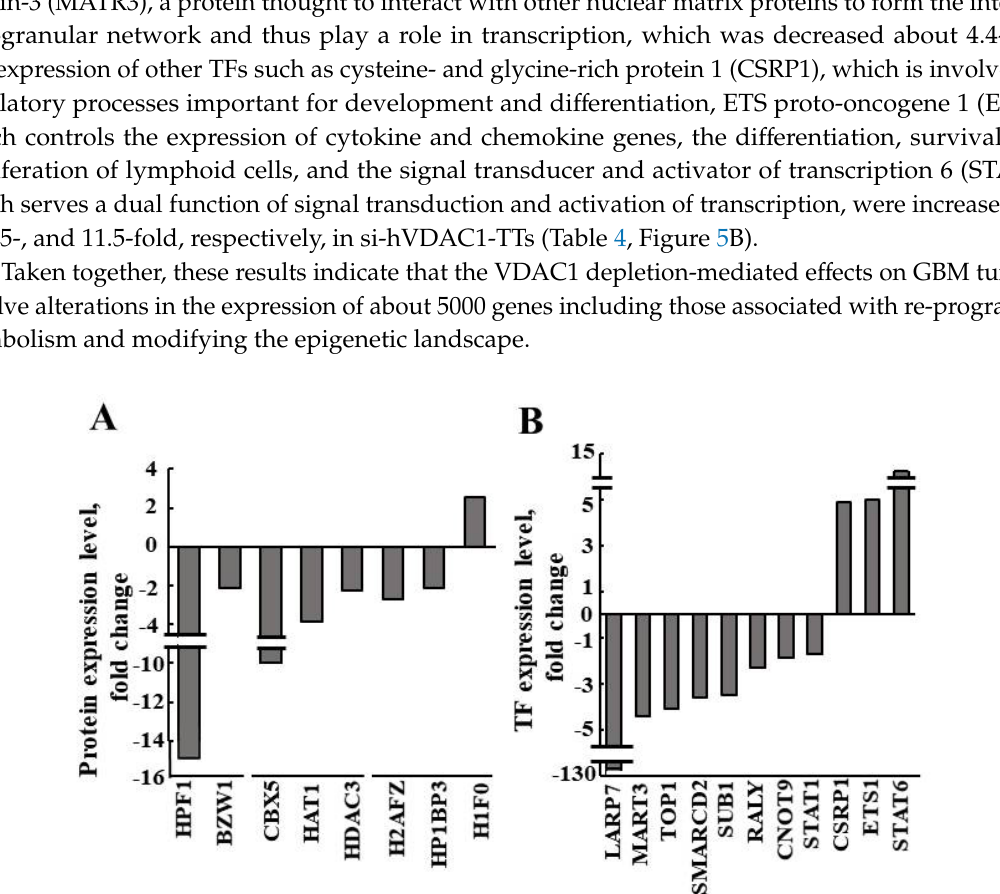
Table 3. Histones and histone-associated proteins differentially expressed in si-NT-TTs and si- hVDAC1-TTs, as identified by LC-HR MS/MS. LC-HR MS/MS experiments were performed as described in the Materials and Methods section. Proteins differentially expressed between si-NT-TTs and si-hVDAC1-TTs ( p -value < 0.01, fold change ≥|2|) are presented, along with the name, fold change and p -value, as well as function.